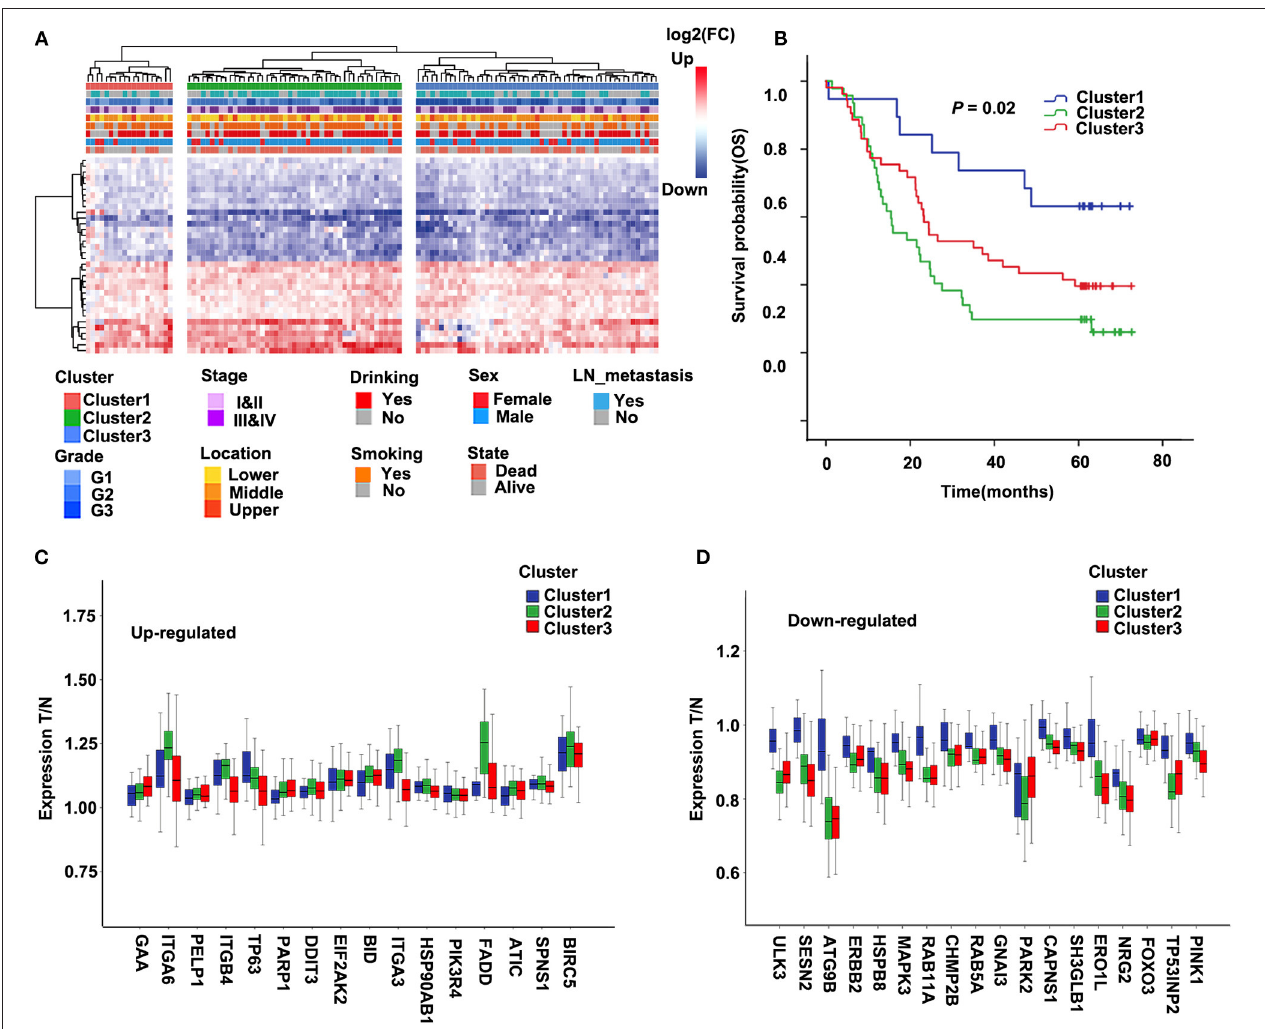
FIGURE 2 | Cluster of differentially expressed autophagy-related genes (ARGs) and Kaplan–Meier (KM) survival plot in the discovery cohort (GSE53624). (A) The heatmap of 34 ARGs. Left: Annotation of cluster and clinical features. The color represents logFC of differential expression. LN, lymph node. (B) Survival curve and Kaplan–Meier analysis of esophageal squamous cell carcinoma (ESCC) patients by the cluster. OS, overall survival. (C,D) The ratio of tumor to normal expression of up- and down-ARGs in Cluster1–3; the ordinate shows the ratio of tumor to normal after normalization of expression.